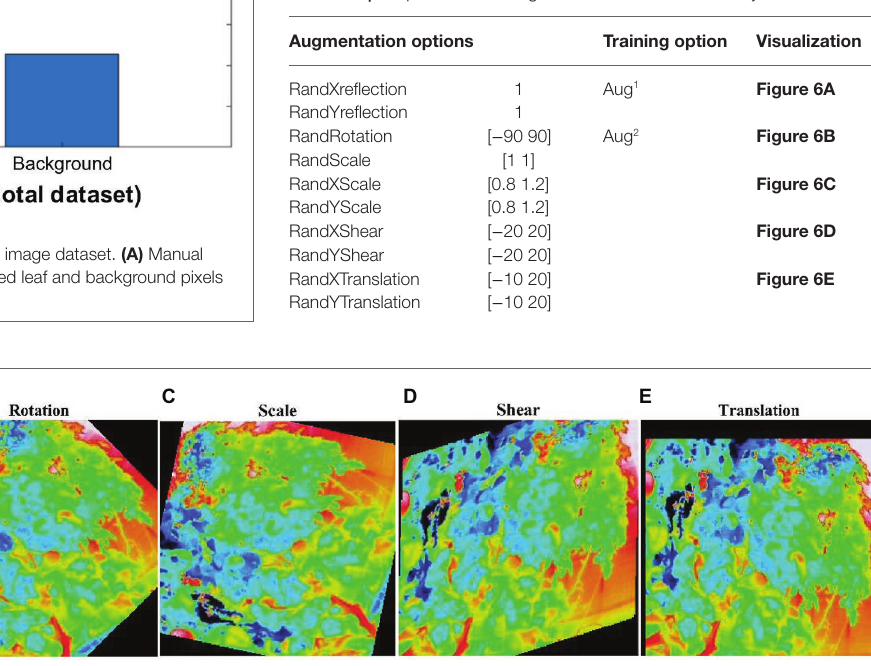
TABLE 3 | Properties of the augmented datasets for DL